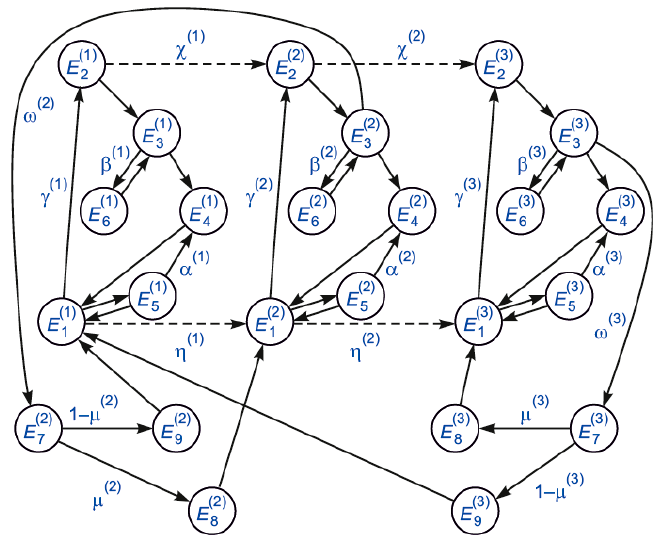
Figure 10. Graph of the model of operation, degradation and renewal of the CTS fleet with incomplete resource recovery.